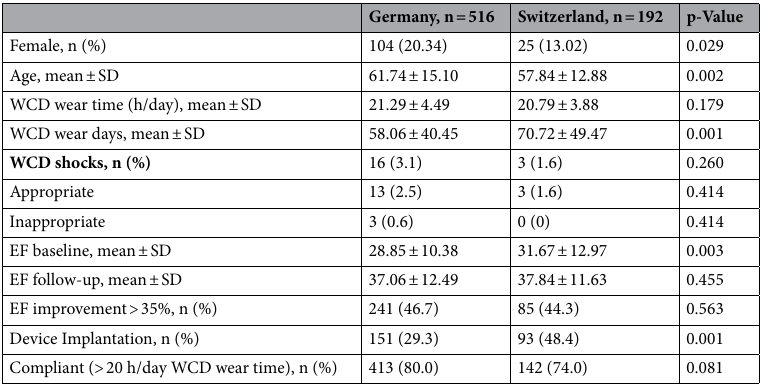
Table 5. Baseline characteristics of WCD patients in Germany compared to